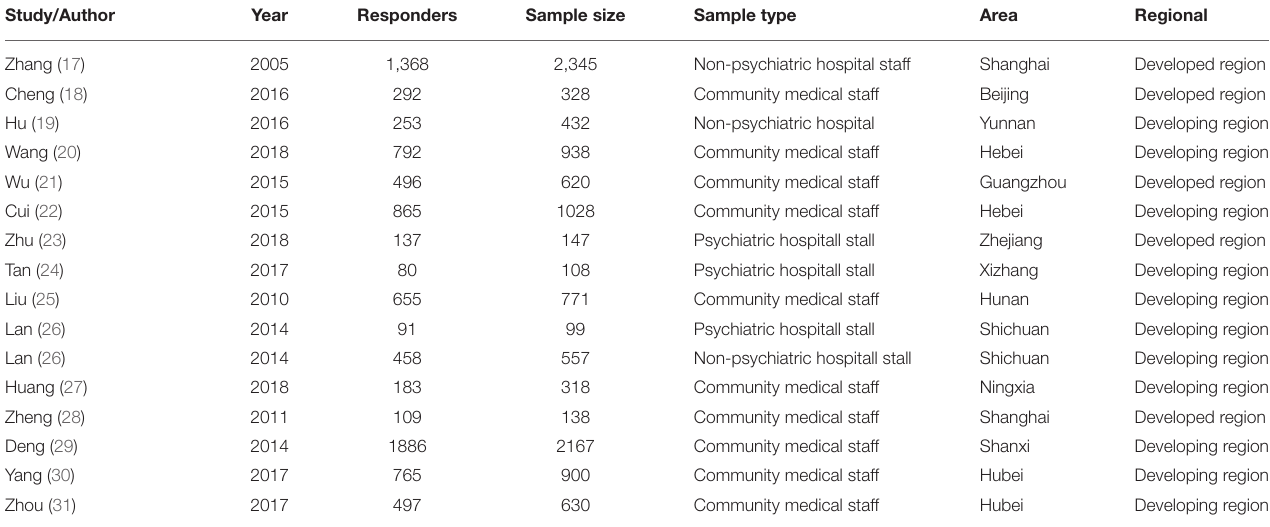
TABLE 1 | The basic information and data of all included studies in the